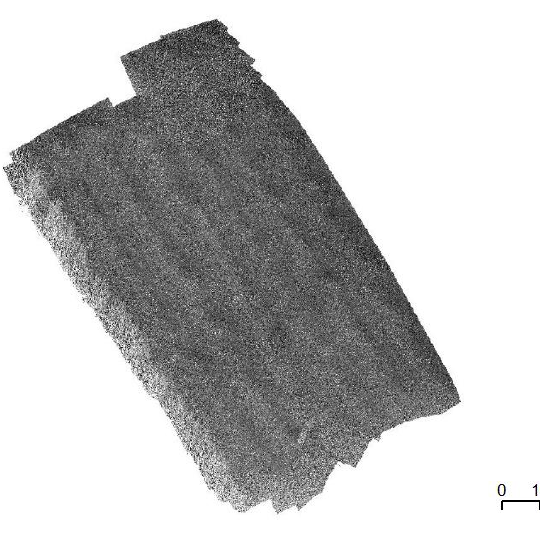
Figure 4. NDVI map of bare soil computed with